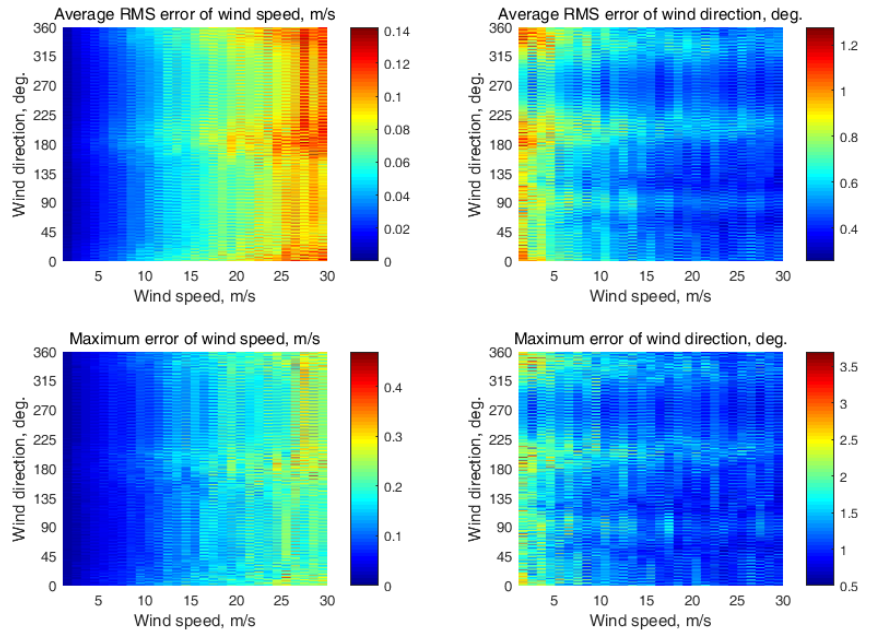
Figure A18. Semicircular wind retrieval results at the (45°, 50°, 55°) incidence angle combination.